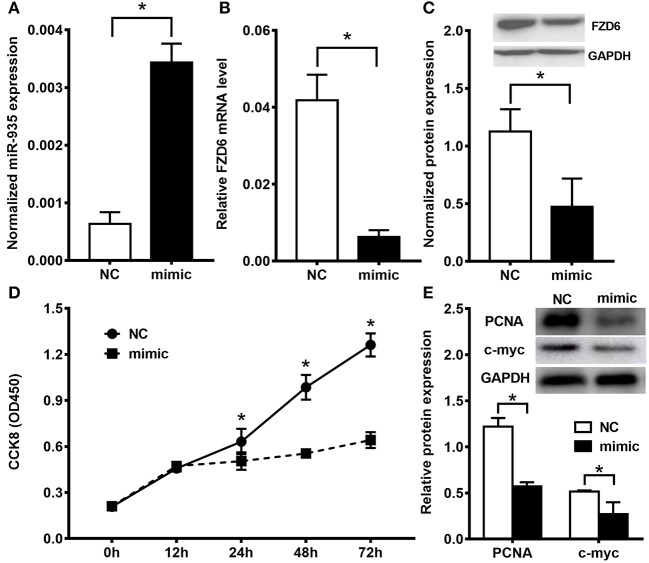
The miR-935/FZD6 axis modulates cell proliferation in the patient-derived glioblastoma cell line model. (A) The miR-935 expression was significantly enhanced by the miR-935 treatment in the patient-derived glioblastoma cell line (mimic) when compared to the NC-treated cells. The FZD6 mRNA (B) and protein (C) expression were downregulated by the miR-935 mimic treatment. (D) The CCK8 assay showed that the miR-935 mimics significantly decreased the cell proliferation of patient-derived glioblastoma cells. (E) The representative Western blotting and bar chat showed that the principle proliferation related to biomarkers were depressed by the miR-935-mimic treatment in patient-derived glioblastoma cells; *p < 0.05, when compared between the indicated groups.